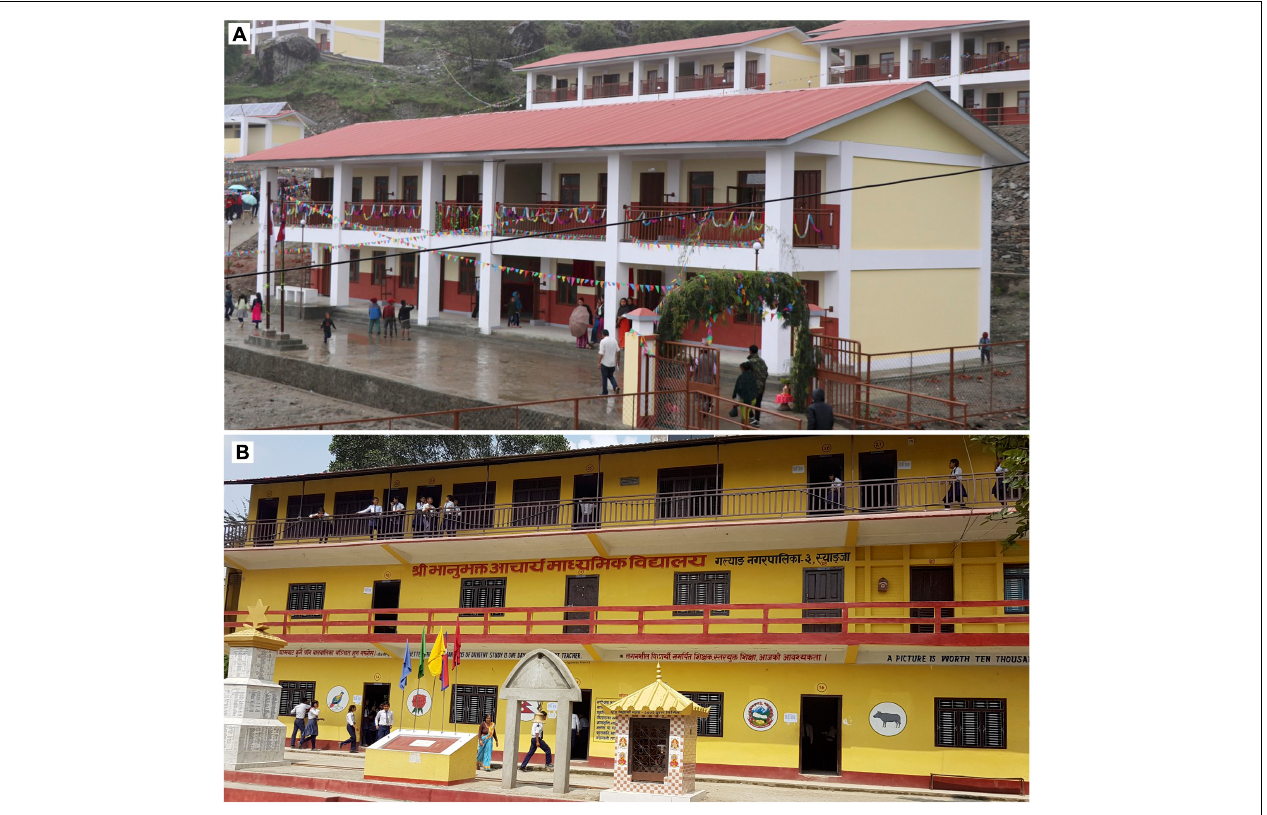
FIGURE 2 | School buildings participating in our program. (A) Shree Himalaya Secondary School in Barpak, Gorkha district. A reinforced cement concrete (RCC) building was newly constructed after the 2015 Gorkha earthquake. A total of 672 students study in the school. (B) Shree Bhanubhakta Acharya Secondary School in Galyang, Syangja district. RCC building, but the third story is not cemented: it is brick, with tin roof on top. A total of 925 students study in this school.